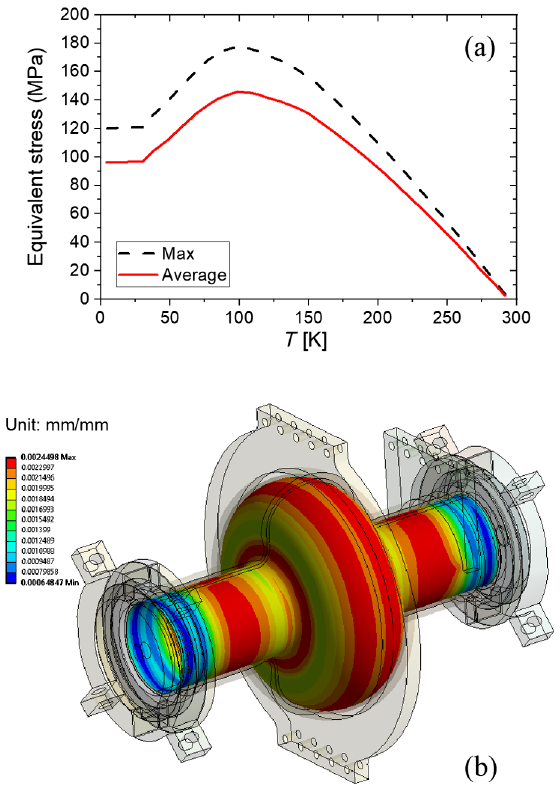
FIG. 8. (a) Maximum and average equivalent (von Mises) stress as a function of temperature and (b) equivalent strain at 4 K in the Nb 3 Sn layer for the prototype cavity with the Cu structure shown in Fig. 7 on the outer